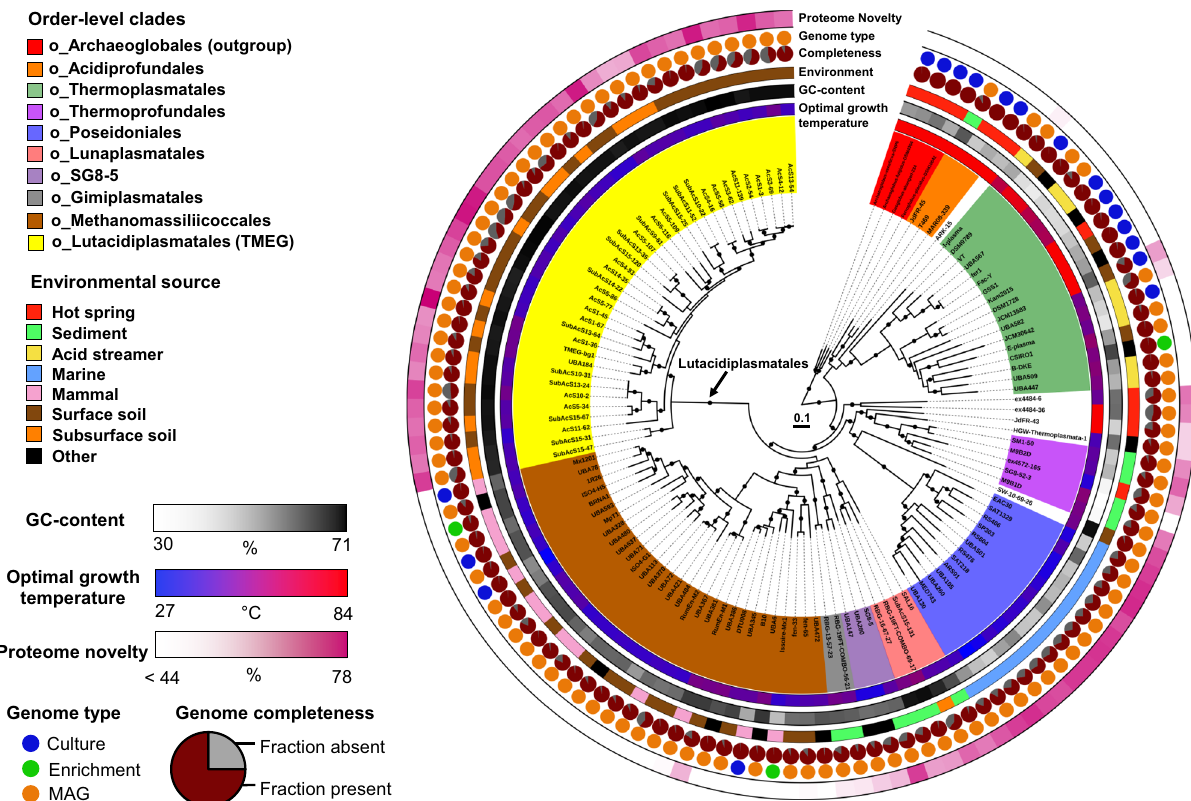
Fig. 2 Phylogenomic tree of Thermoplasmatota. This tree includes 120 Thermoplasmatota genomes from a variety of environments. The tree was inferred by maximum likelihood from 108 concatenated marker genes, aligned separately and analysed using the best- fi tting model for each alignment. The tree was rooted with four Archaeoglobales genomes. Dots indicate branches with >95% UFBoot and SH-aLRT support. As previously published studies have recovered different phylogenies for Thermoplasmatota, species trees inferred using a variety of approaches were compared. This phylogeny was the most likely, based on approximately unbiased testing and this topology being reconstructed in six of the seven approaches applied here (see SI Phylogenomics). Protein novelty is de fi ned as the percentage of encoded proteins that lack a close homologue in the arCOG database. Detailed genome information is given in Supplementary Data